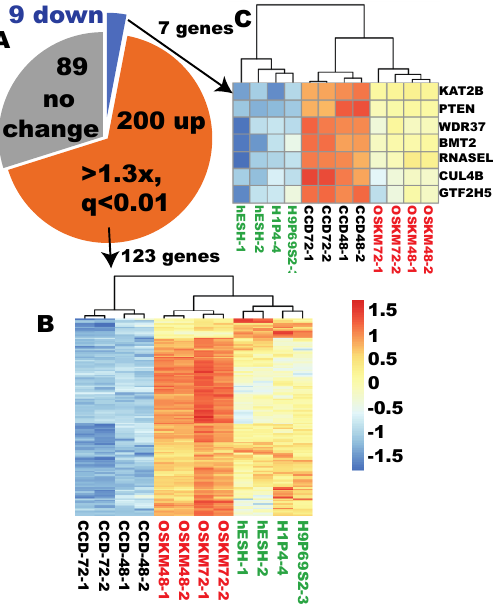
Figure 10. OSKM quickly reprogrammed RB to the pluripotent state in an independent fibroblast line. ( A ) Pie diagram showing predominant upregulation of RB genes during early iPSC reprogramming of the CCD fibroblasts. ( B ) Out of the 200 OSKM-upregulated genes, 123 were ESC-enriched (q < 0.05. >1.3×). Note the clustering of RB genes with ESCs and away from fibroblasts. ( C ) The fibroblast-enriched RB genes predominantly underwent legitimate downreprogramming, although insufficiently. Human ESC samples are indicated by green text; CCD fibroblasts underwent OSKM-mediated reprogramming are indicated by red color.